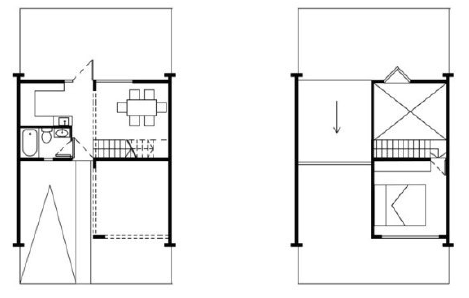
Figure 5. Floor plan of the base house in Las